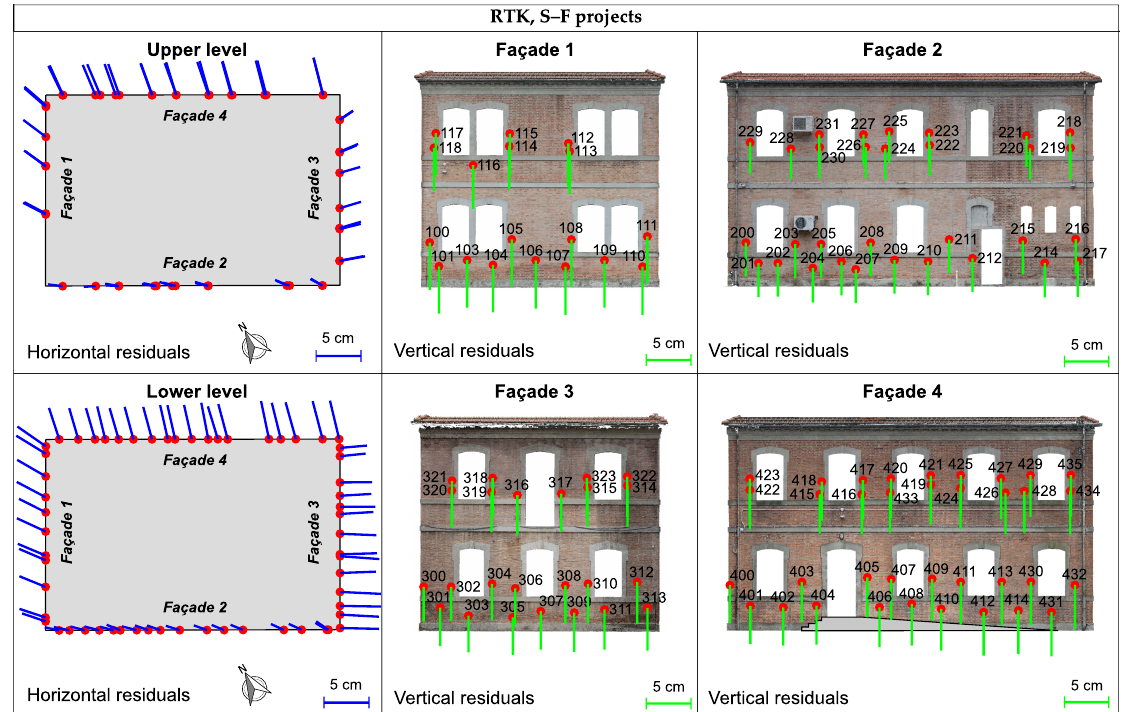
Figure A2. Horizontal and vertical residuals for RTK image dataset processed for single façades (S–F).